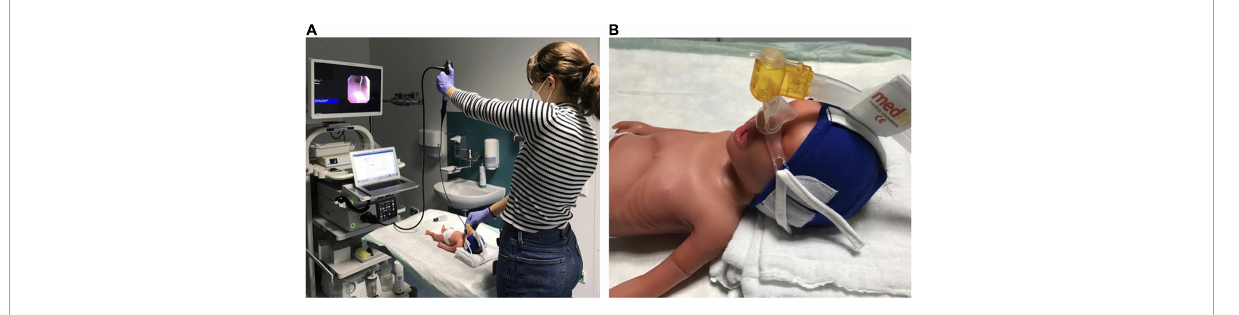
FIGURE1 Experimental setup. (A) The simulator was positioned on a height-adjustable table in front of the bronchoscopy tower with the head towards the participant. Participants used a 3.1-mm-diameter Olympus EvisExera III digital video bronchoscope (BF-XP190 2711037, Tokyo, Japan) with a 1.2-mm working channel and a CV-190 video processor and xenon light source. Bronchoscope insertion was facilitated with lubricating gel. (B) VLBW infant simulator positioning with the head slightly elevated on a pad to optimize the view for tracheoscopy. A continuous positive airway pressure device (Fisher andPaykel, Schorndorf, Germany) was placed on the nose to simulate respiratory support during stabilization in the delivery room.